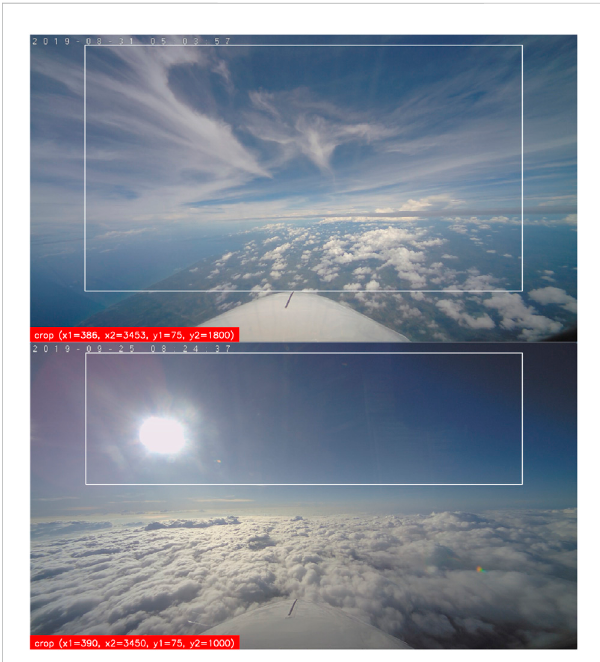
Examples of forward-viewing imagery from the CAMP 2 Ex campaign.Thetopimageisapartof setD ,whilethebottomimageisa partof setK .Theimagesarecroppedtoremovethenoseoftheplane, remove the timestamp, and to focus on clouds positioned above the aircraft (white outline). The top image has a cirrus_clouds tag that is labeled as Present , while the bottom image is labeled as Missing